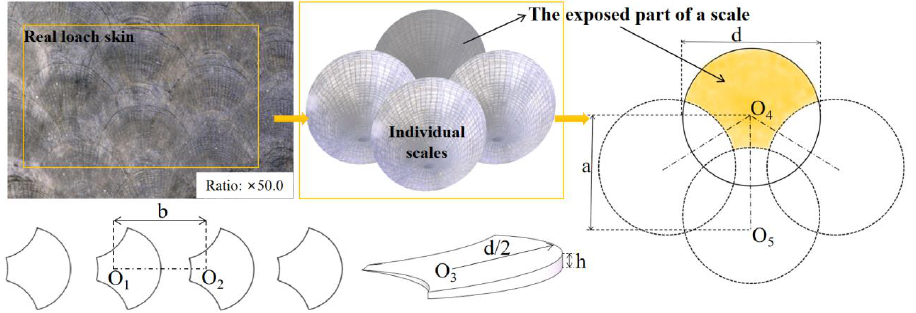
Figure 7. Structure unit parameters.